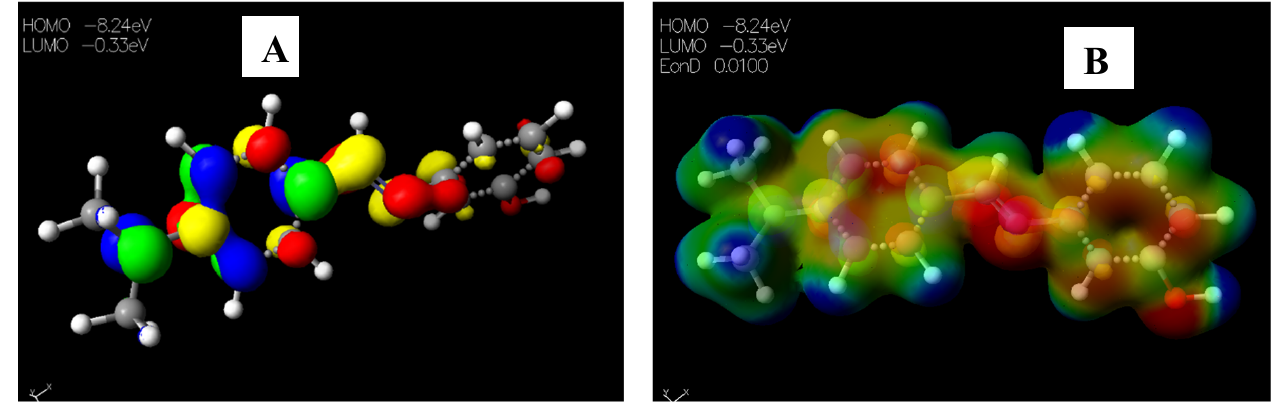
Figure 10. Images showing the ( A ) Highest occupied molecular orbital (HOMO) and Lowest unoc-